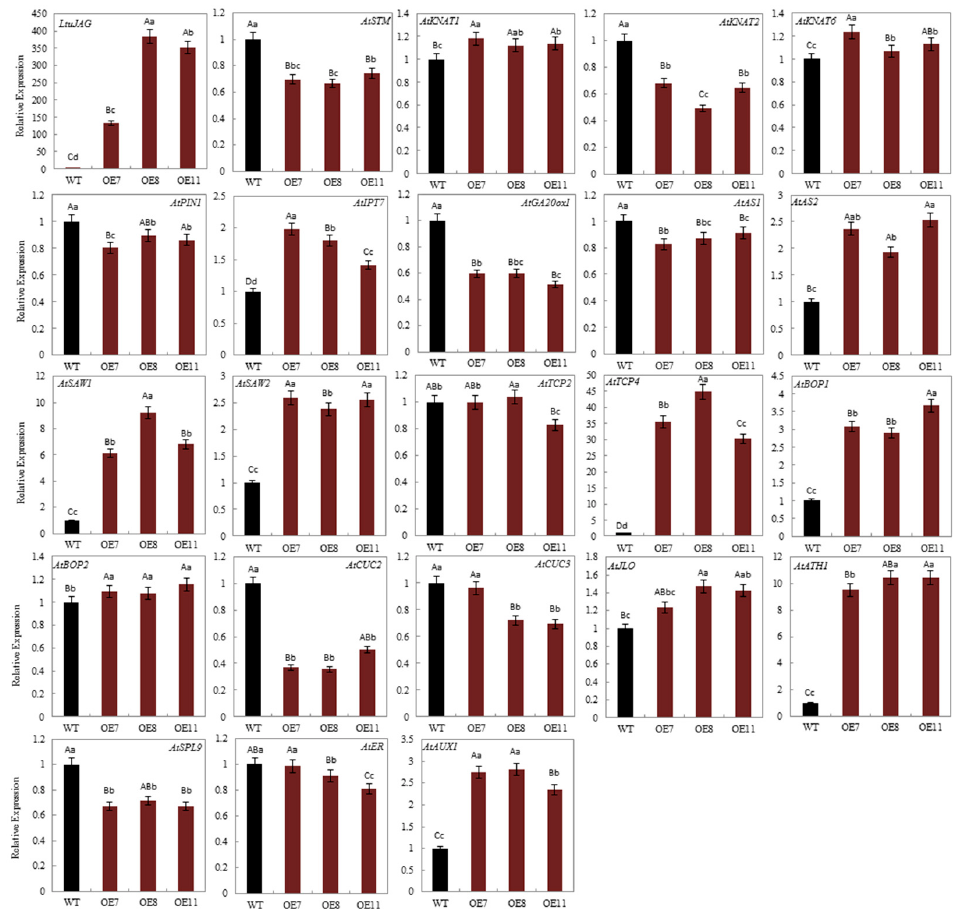
Figure 7. Quantitative RT-PCR analysis of LtuJAG and genes in relation to leaf development in the ten-day-old wild type (WT) and three independent LtuJAG overexpression lines, OE7, OE8 and OE11. ACTIN2 served as the reference gene. The value of genes expression level in WT was set to “1” as a control, the error bars represent the standard deviation among three biological replicates. Data were analyzed statistically using the one-way ANOVA Tukey’s test. Different letters indicate significant differences at p < 0.01 and p < 0.05